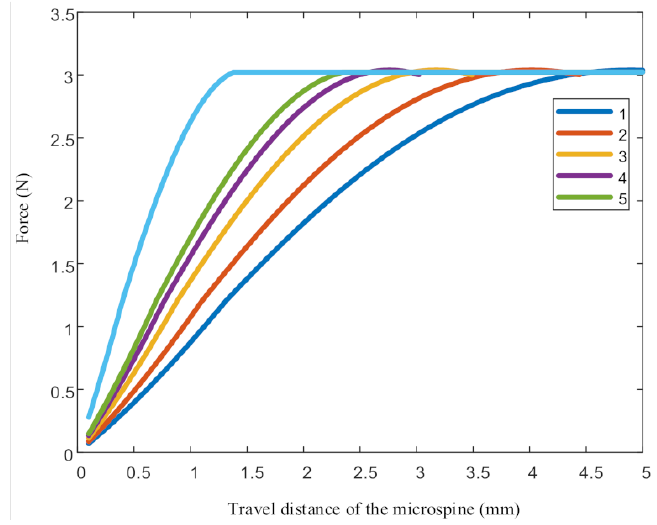
Figure 9. Relationship between stiffness and displacement of different recovery springs. The stiffness of 1 to 5 in the figure is 1.5, 2, 3, 4 and 5 (N/mm)